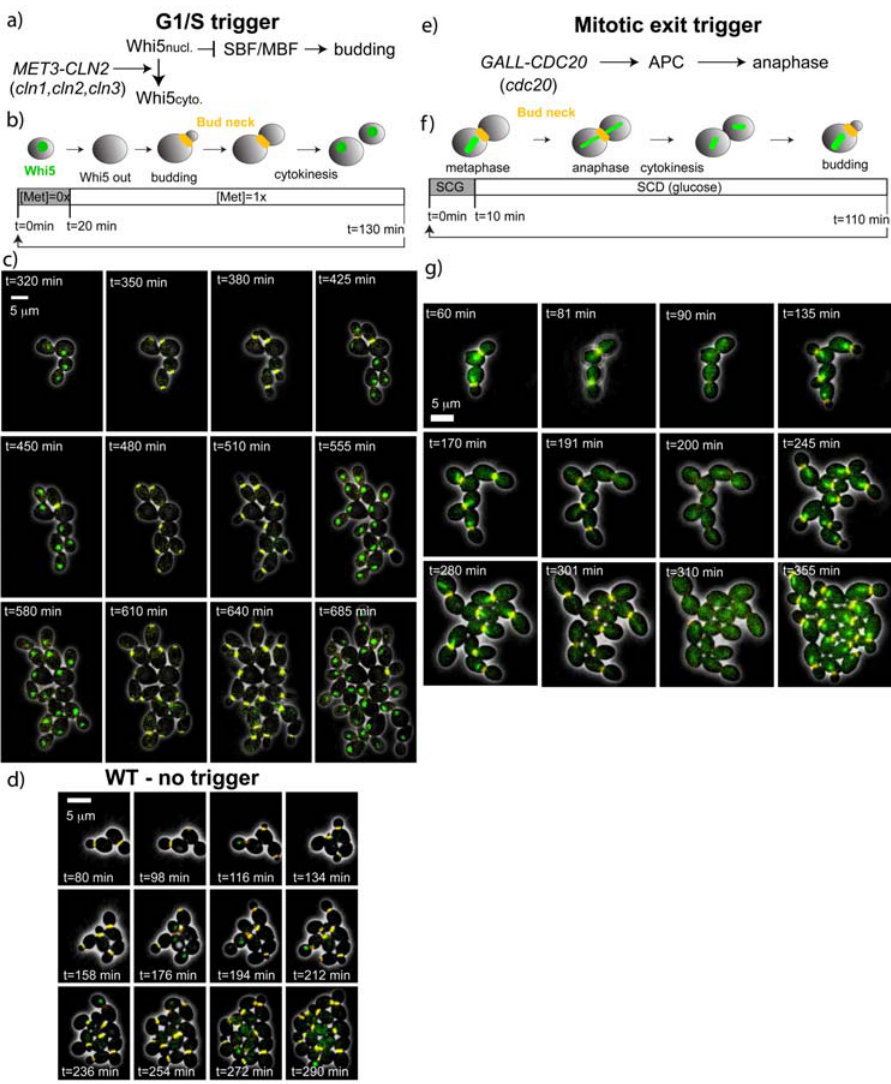
Figure 4. G1/S and mitotic exit trigger; a,e) Sketches of the genetic networks involved in triggering of the G1/S transition and anaphase b,f) The fluorescent markers and design of the periodic pulses c,g) Overlay of phase and fluorescence images during a pulsing experiment. The colors correspond to the schematic in the panel above and the times are chosen to coincide with the events in the schematic. The rows correspond to three successive periods. d) Phase and fluorescence for the growth of WT cells, rows spaced by one